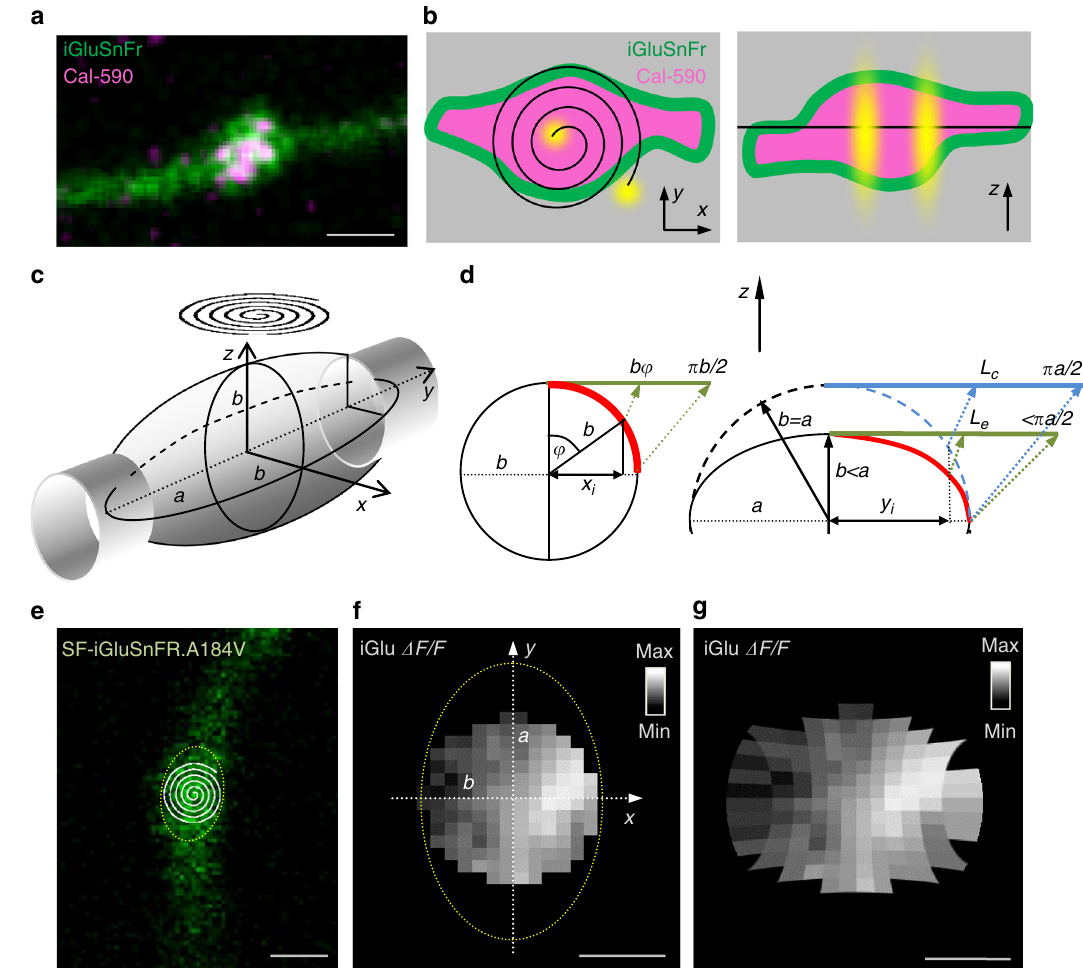
Fig. 6 Nanoscale geometry of presynaptic bouton imaging with two-photon excitation. a CA3 – CA1 axonal bouton (example), two-channel image (SF- iGluSnFR.A184V green, Cal-590 magenta); scale bar, 1 µ m. b Axonal bouton diagram illustrating laser scanning settings, x – y (left) and z (right) planes,